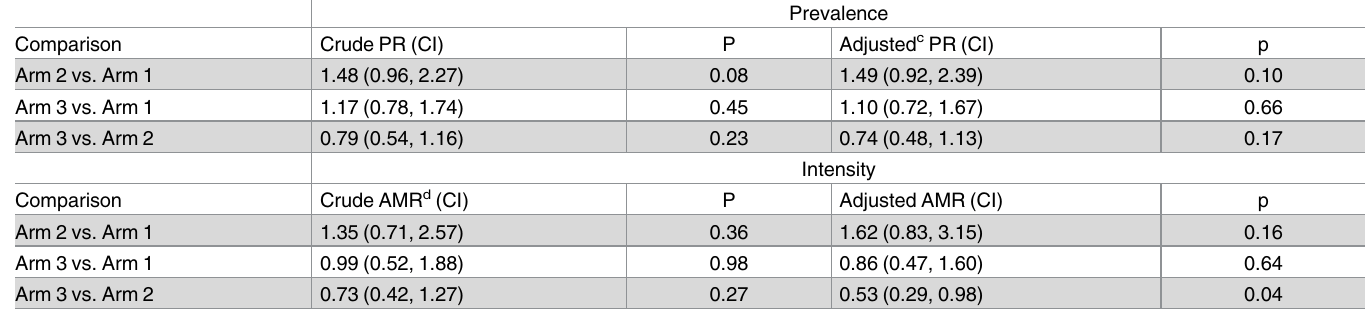
Table 3. Comparisons of 9–12 year old prevalenceand intensity of S . mansoni infection between arms at year 5. Adjustment of PRs and AMRs are for age, sex, and villagesample size.